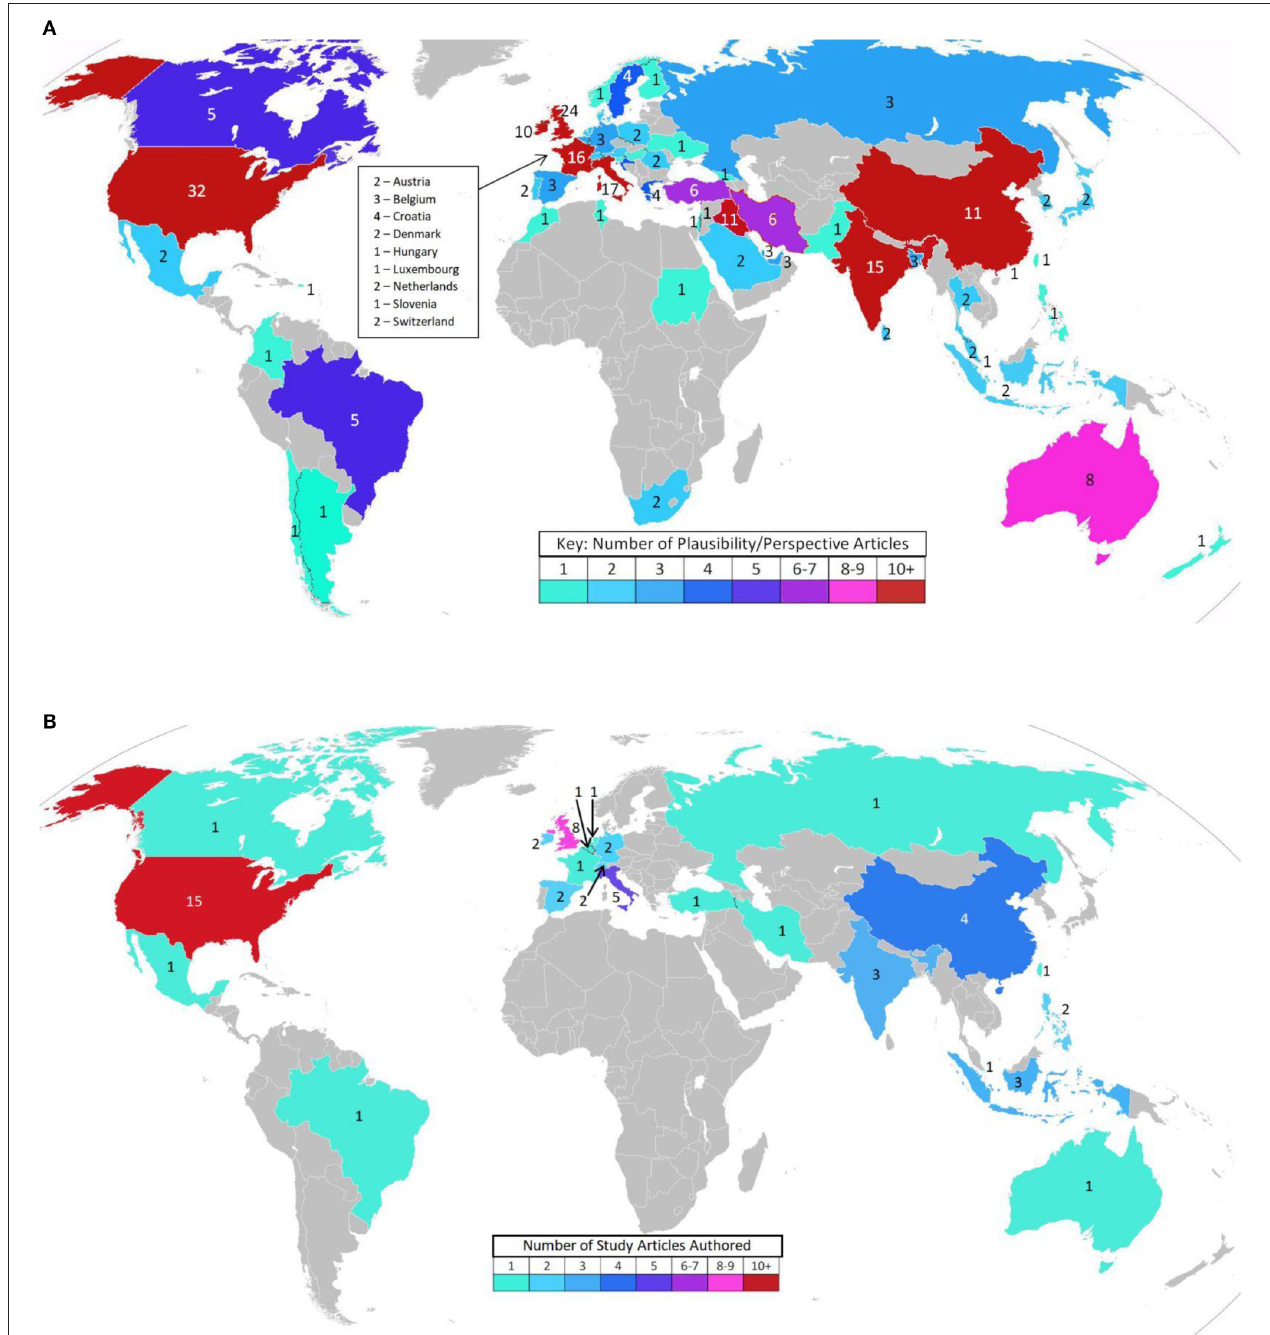
FIGURE 3 | (A) Interest in the topic—Biological plausibility article authors’ locations (141 Articles). (Blank maps from wiki images: Creative Commons, credit: Canuckguy and many others). (B) Interest in the topic – Original research article authors’ locations (47 Articles). (Blank map from wiki images: Creative Commons, credit: Canuckguy and many